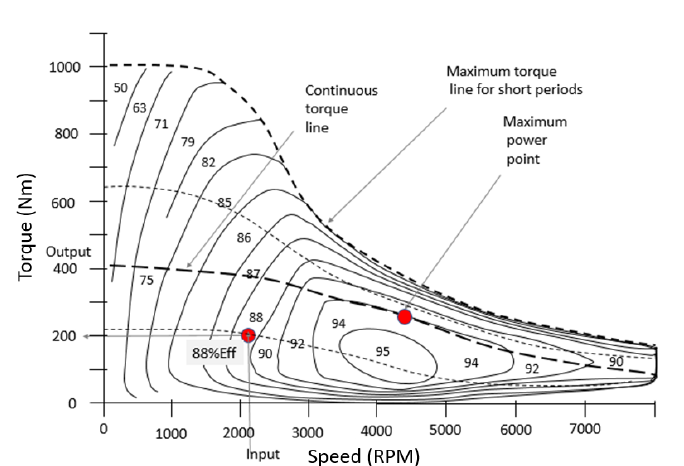
Figure 3. Efficiency Map for an electric motor.